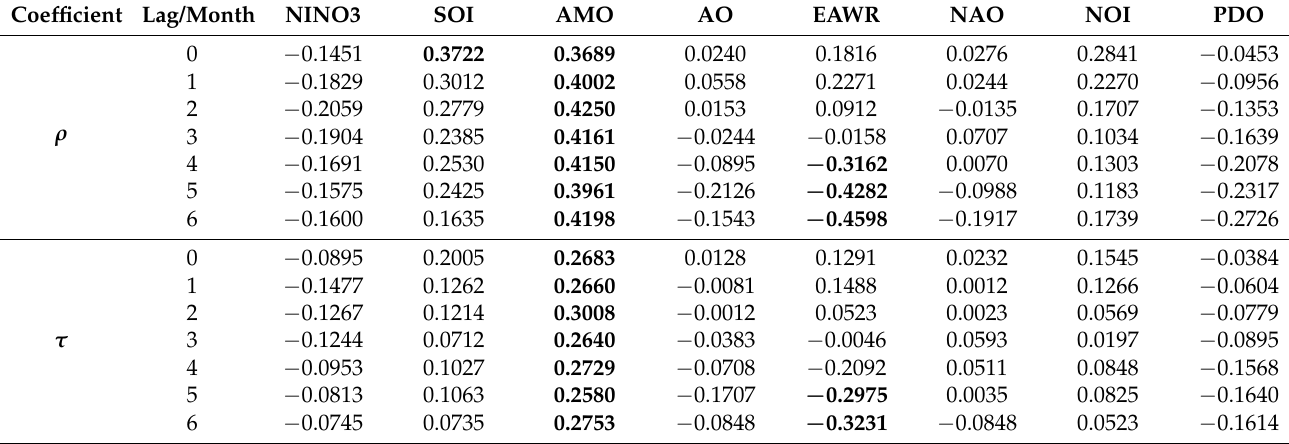
Table A6. The Pearson correlation coefficient ρ and the Kendall correlation coefficient τ between the time series of ET 0 in spring and climate indices under lags from 0- to 6- month. Bold means statistically significant at the level of 0.05. Coefficient